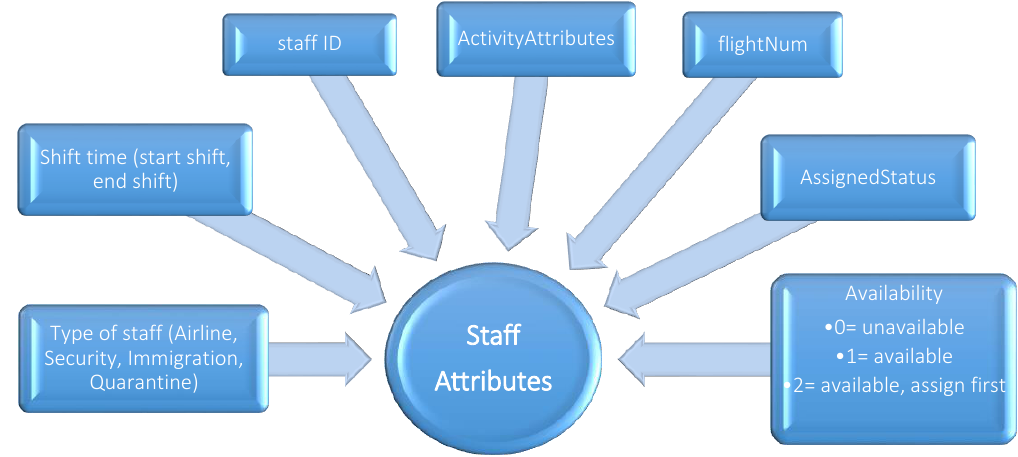
Figure 3. Sta ff attributes for the ARM Figure 3. Staff attributes for the ARM model.